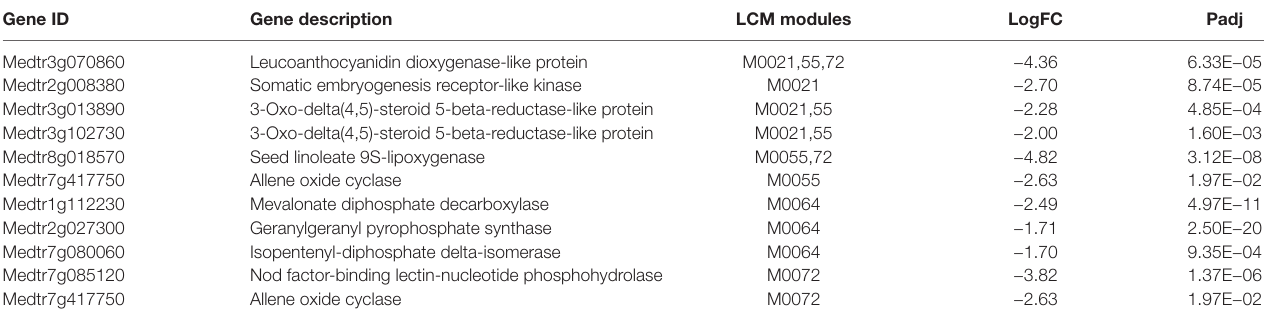
TABlE 2 | Genes assigned to modules consisting entirely of down-regulated genes at 24 h post-inoculation (24D). If a gene appeared in multiple modules, only the last digits of the number are listed for the additional modules. LogFC is X, Padj is Y.